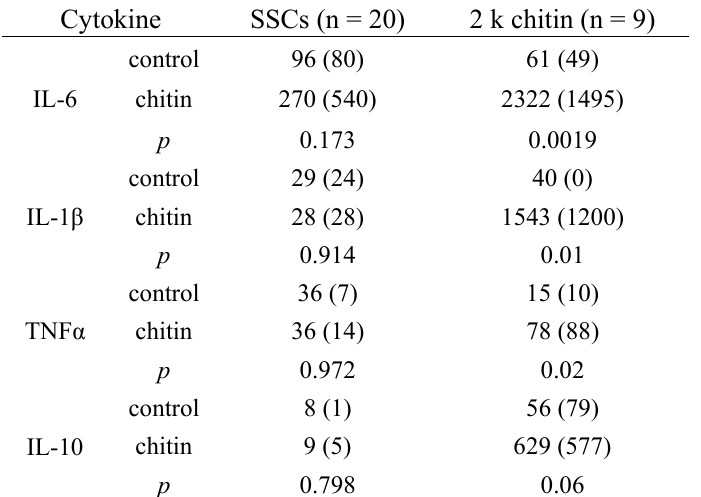
Table 1. Cytokines induced by exposure of crab chitin to